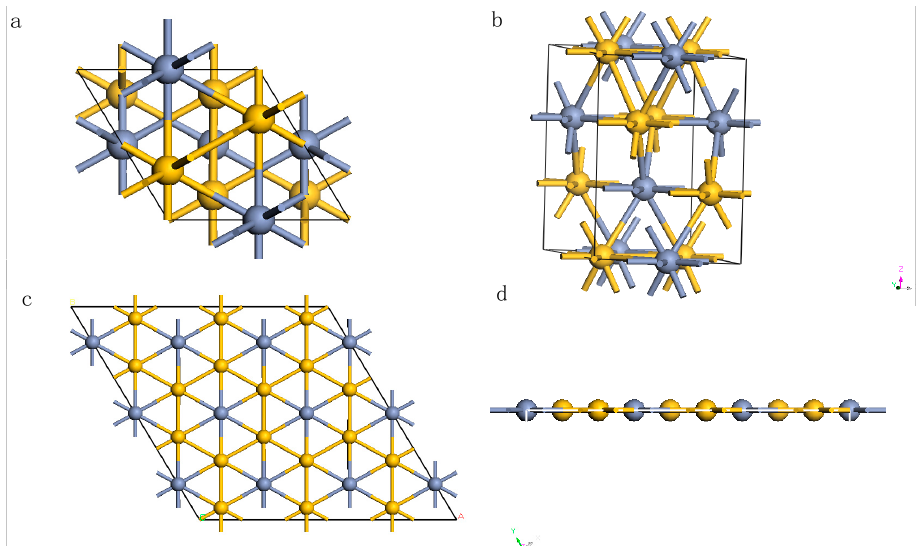
Figure 1. Top and side views of bulk and monolayer CrSi 2 after geometry optimization. Figure 1 ( a ) and Figure 1 ( b ) describe top view and side view of the bulk CrSi 2 crystalline structure, Figure 1 ( c ) and ( d ) depict top view and side view of the monolayer CrSi 2 crystalline structure, respectively. Yellow balls and blue balls represent Si and Cr atoms.